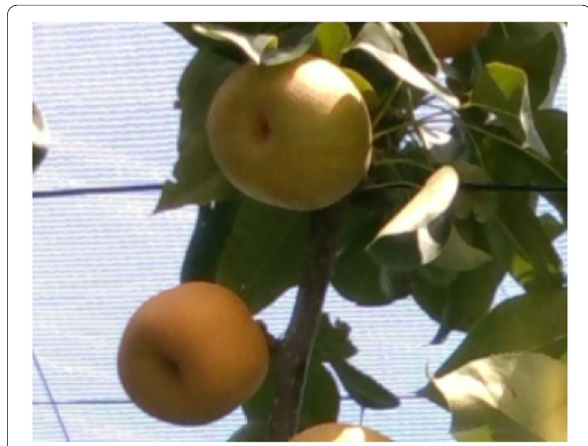
Fig. 14 Example of easy confirmation of harvestability